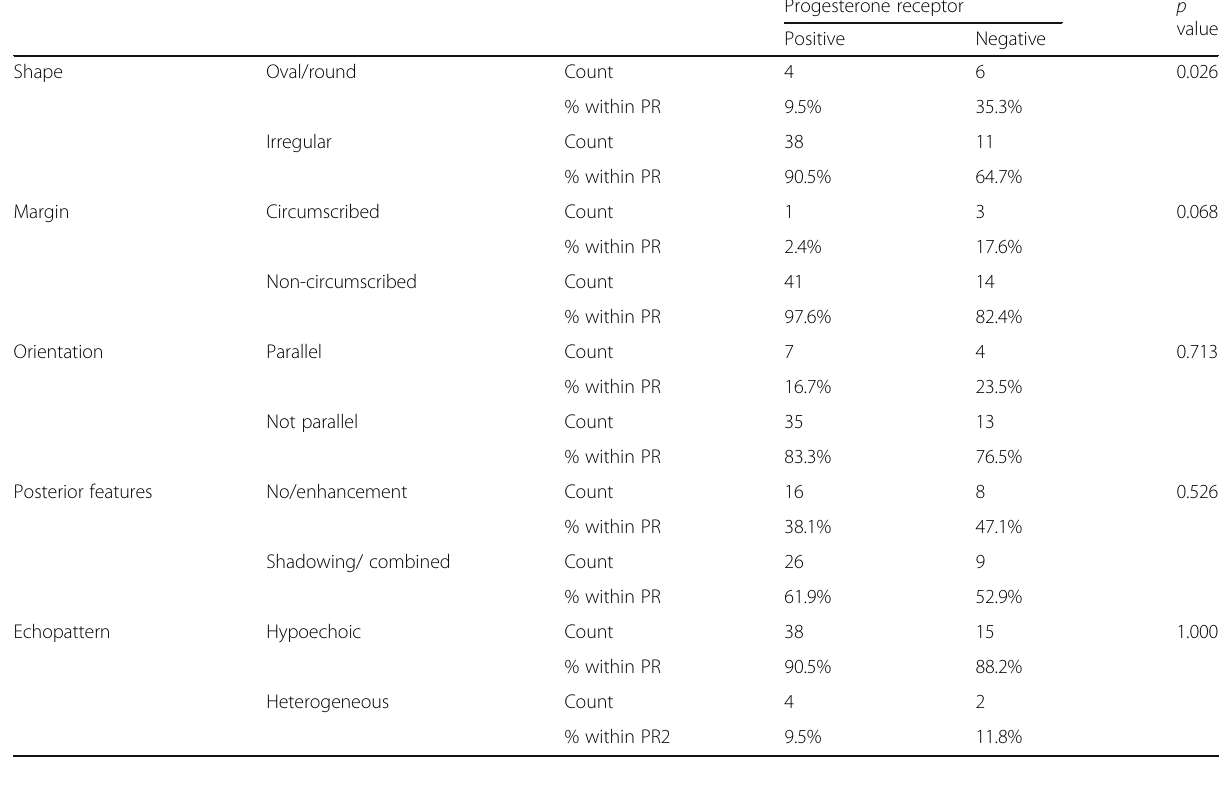
Progesterone receptor